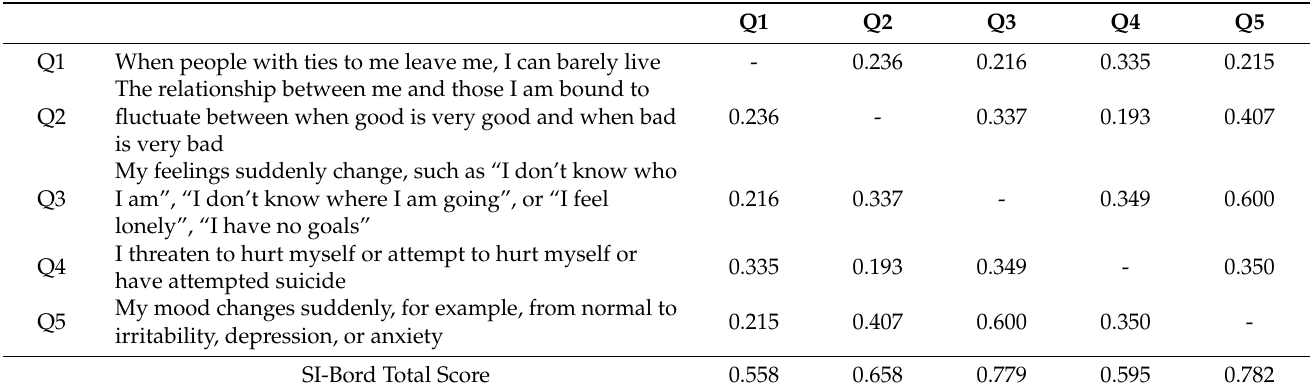
Table 2. Inter-item cross-correlation and SI-Bord total